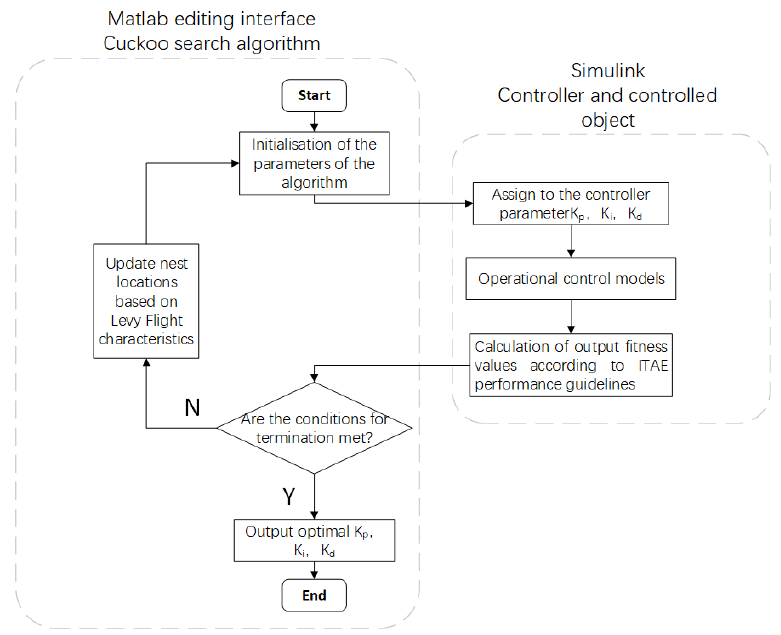
Figure 10. Schematic diagram of the process of optimizing and controlling the parameters of the cuckoo search algorithm.